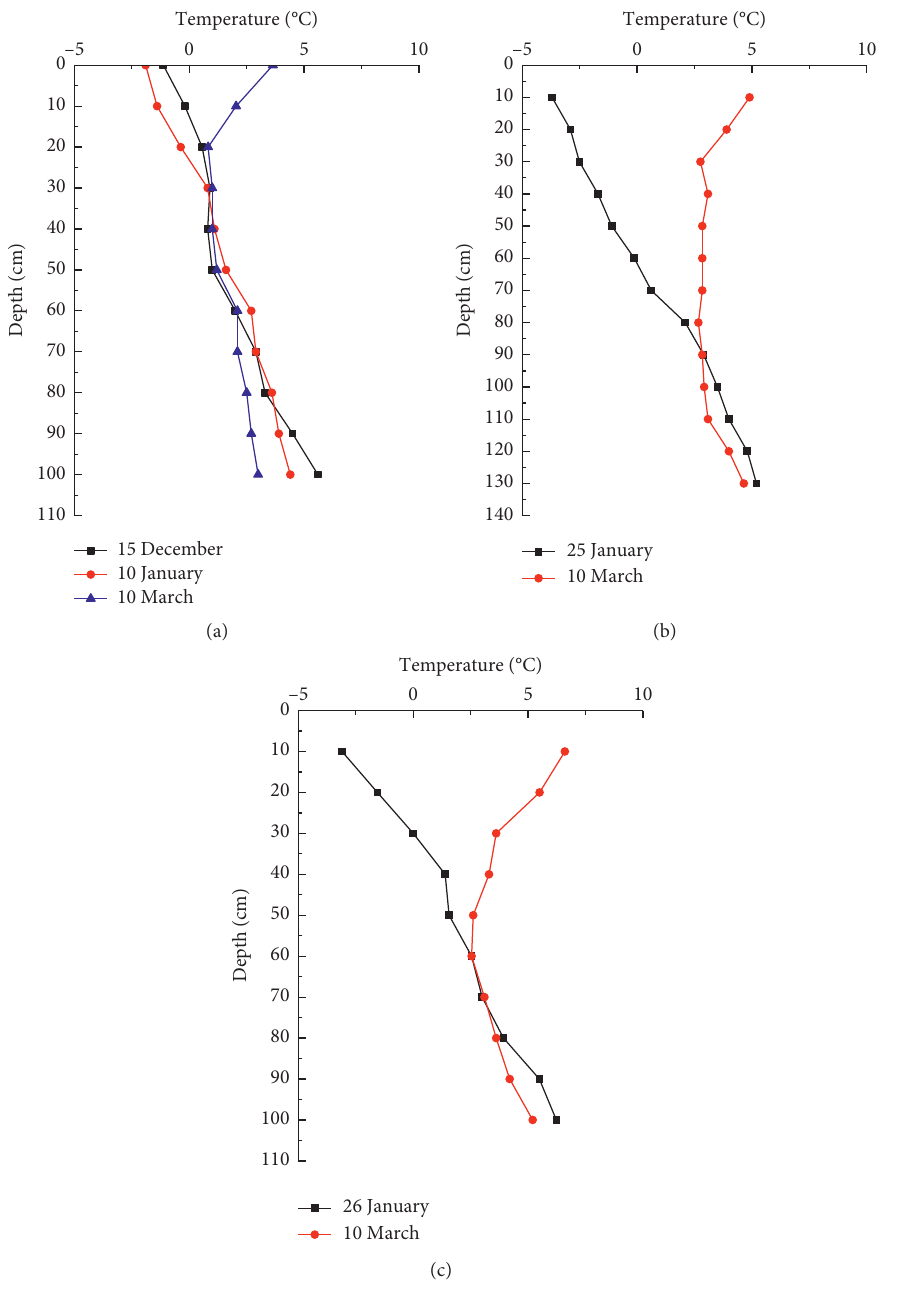
Figure 2: Temperature variation of shallow loess with time at different sites. (a) Bin County. (b) Luochuan. (c)